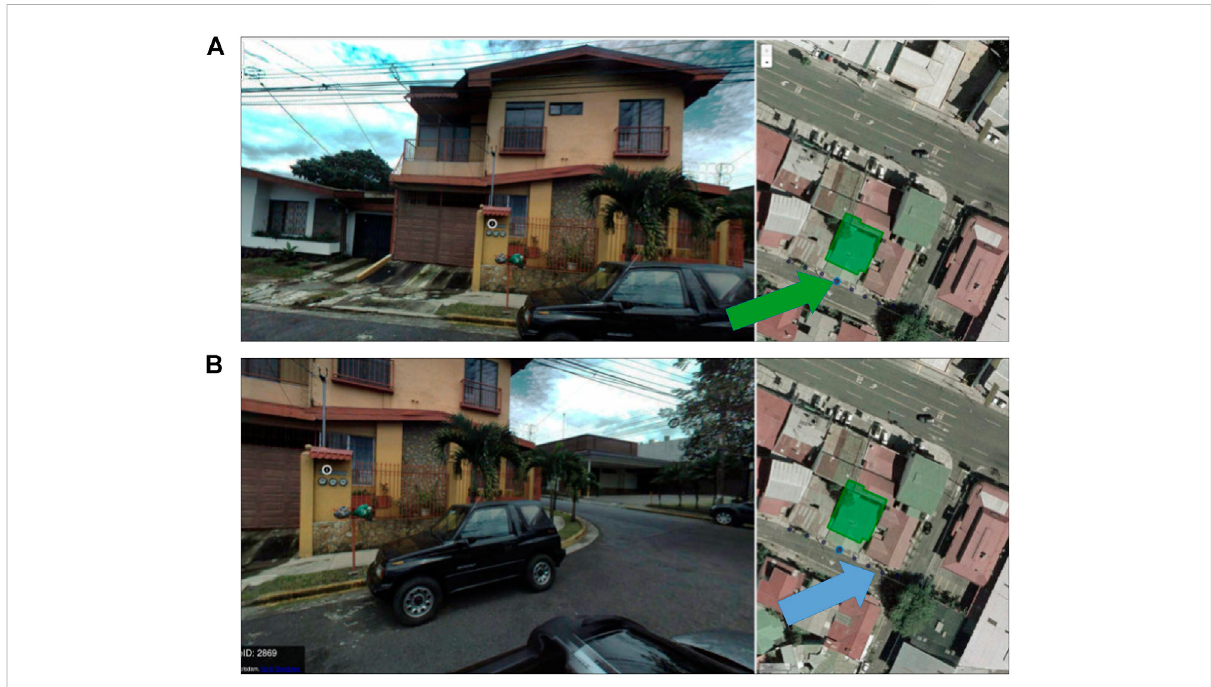
FIGURE 11 Dif fi culty with image position. (A) corresponds to the incorrect location of the image, pointed by the green arrow; (B) to the actual (correct) location, pointed by the blue arrow.